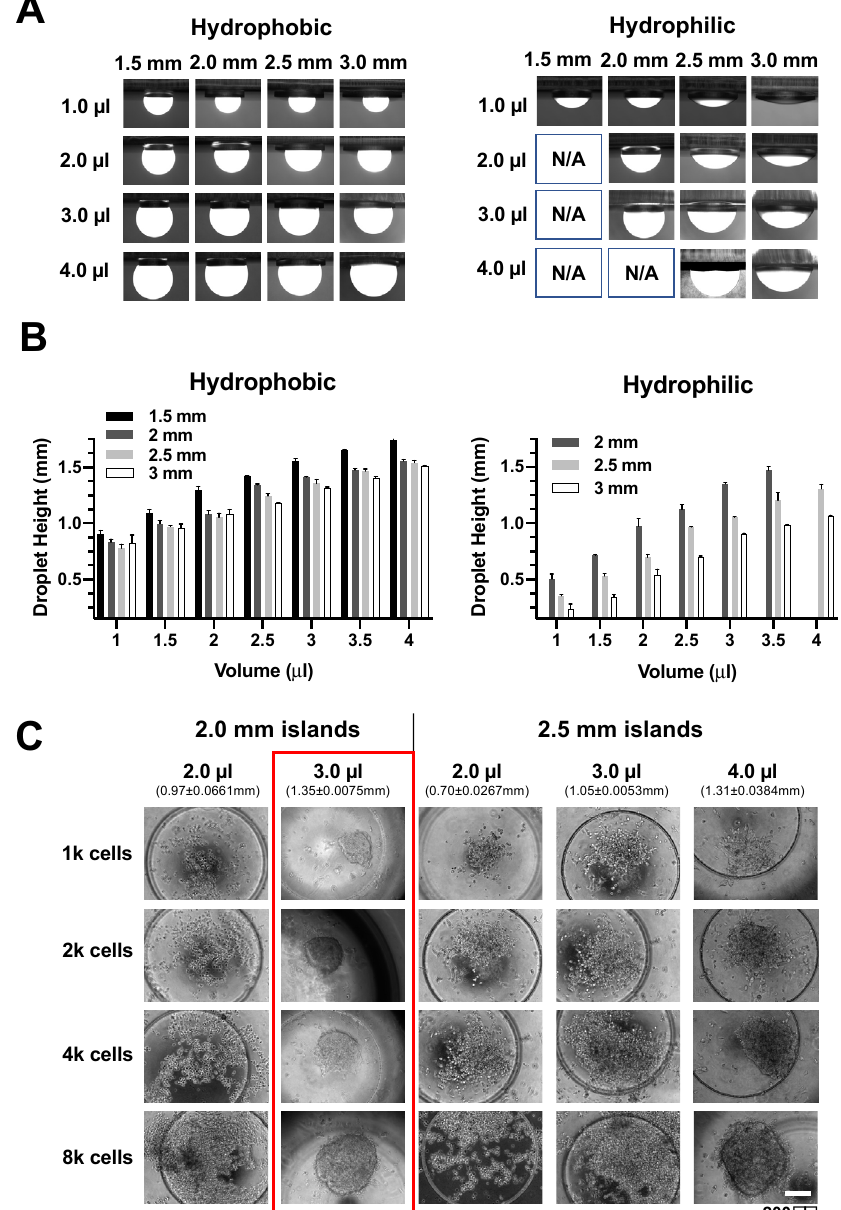
Figure 3. Optimizations for on-chip spheroid hanging drop culture. ( A ) Fluorescence images of FITC-containing droplets on hydrophobic and hydrophilic extruded circular island features. ( B ) Droplet height with different island diameter and volume of droplets on both hydrophobic and hydrophilic surfaces. Data was presented as mean ± SD. ( n = 3) ( C ) Effect of cell number, droplet volumes, and island size on MCF-7 spheroid formation. Patterned islands consist of a microwell feature to facilitate spheroid centralization.